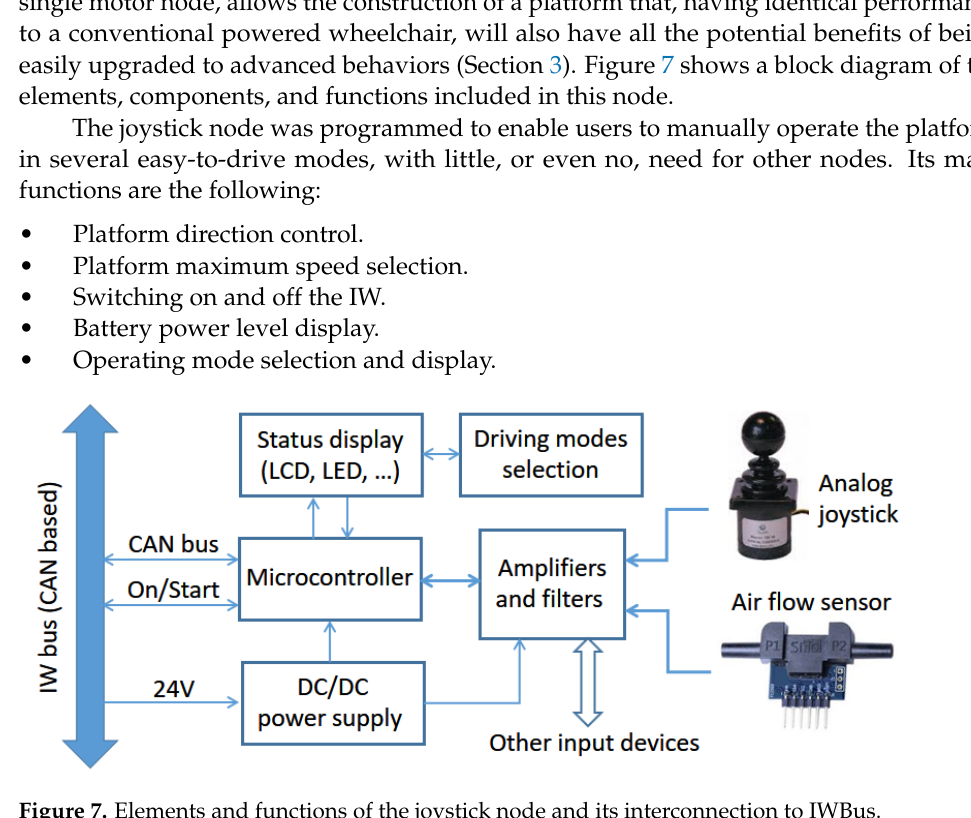
Figure 7. Elements and functions of the joystick node and its interconnection to